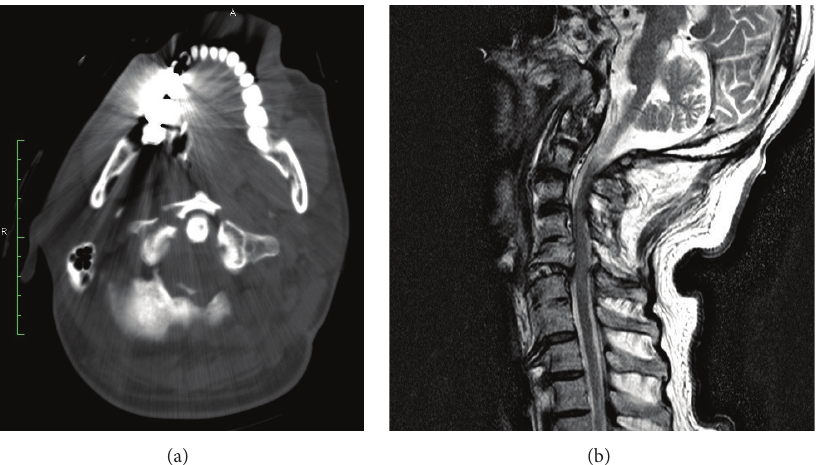
Figure 1: Computed tomography (CT) and magnetic resonance imaging (MRI) examination on arrival. (a) shows a Jefferson fracture. (b) shows a sagittal T2-weighted MRI of the cervical spinal cord injury (C1 and C2).